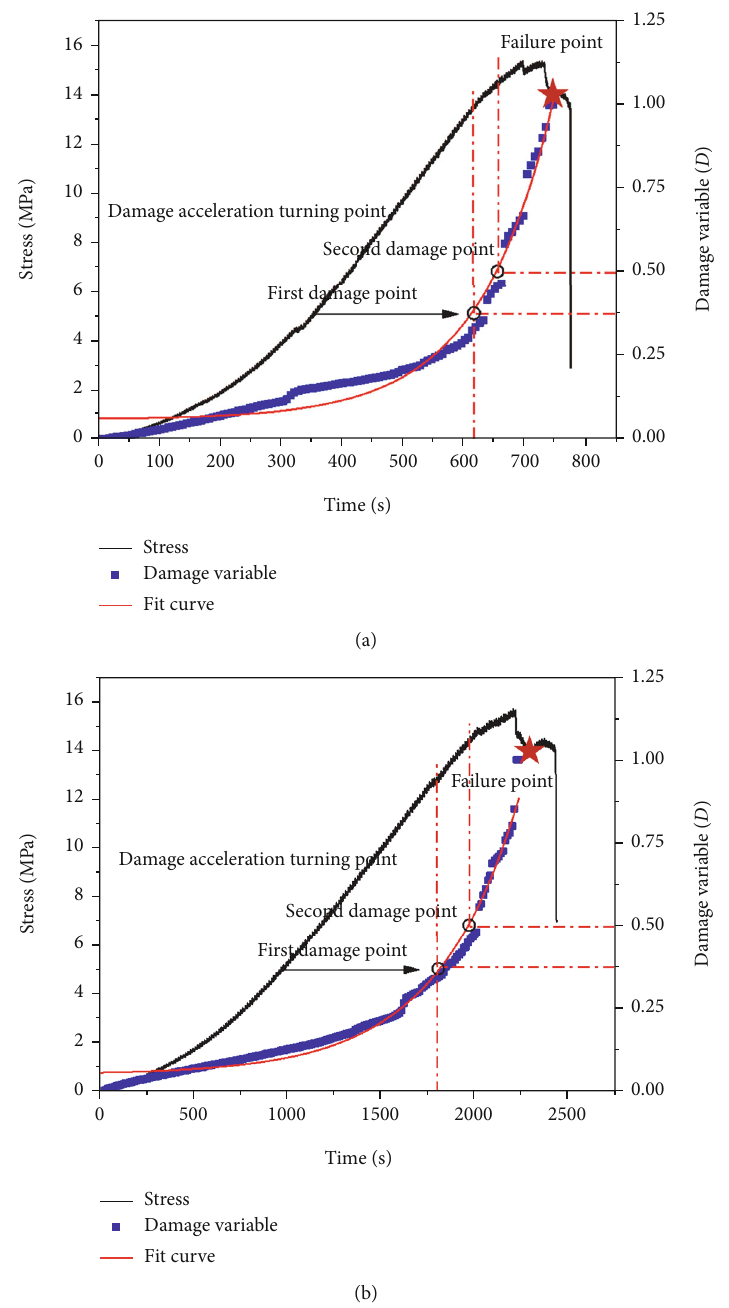
Figure 5: The damage evolution curve of red sandstone under compression. (a) The result of specimen R1. (b) The result of specimen